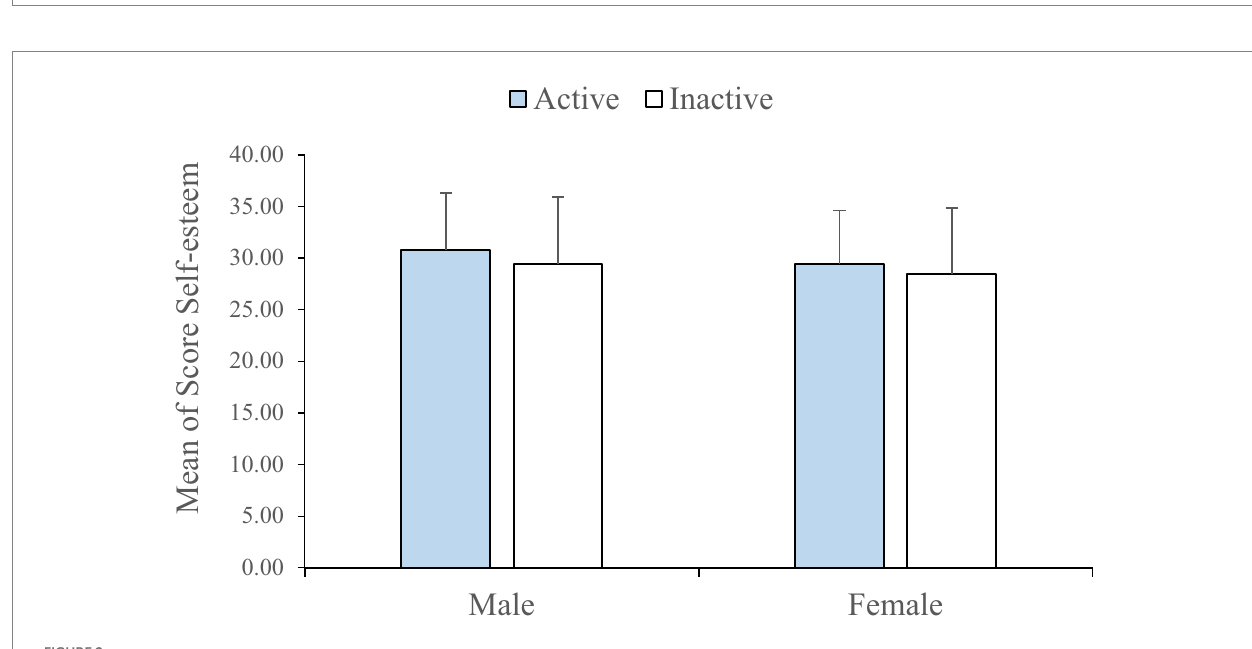
FIGURE 2 Mean self-esteem scores in two active and inactive groups based on